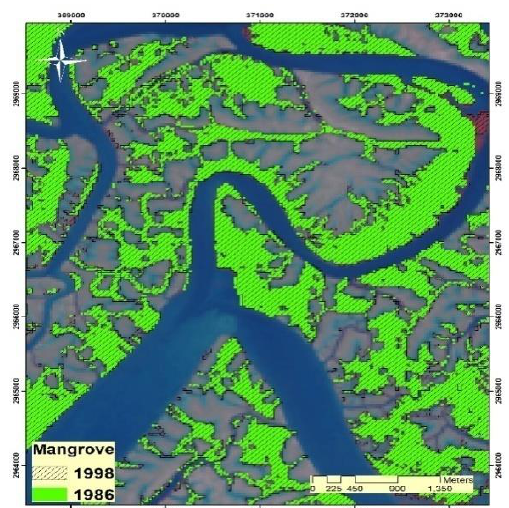
Figure 4. Extent change of Khamir habitat in the periodpre- 1998 Analysis of the fragmentation changes in Khamir